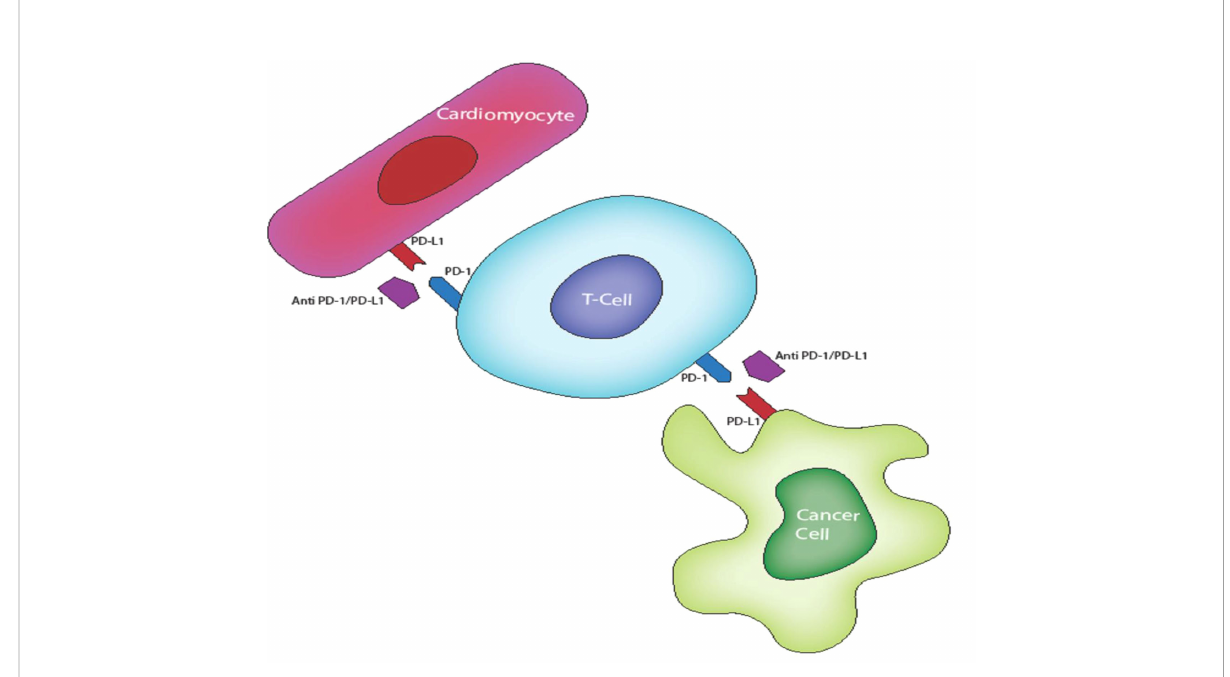
FIGURE 2 PO-L1 expression on cardiac tissues confers protection from activated T cell via P0-1/PO-L1 inhibition of T cells. This inhibition is lost in ICI therapy resulting in an autoimmune T lymphocyte destruction of cardiac